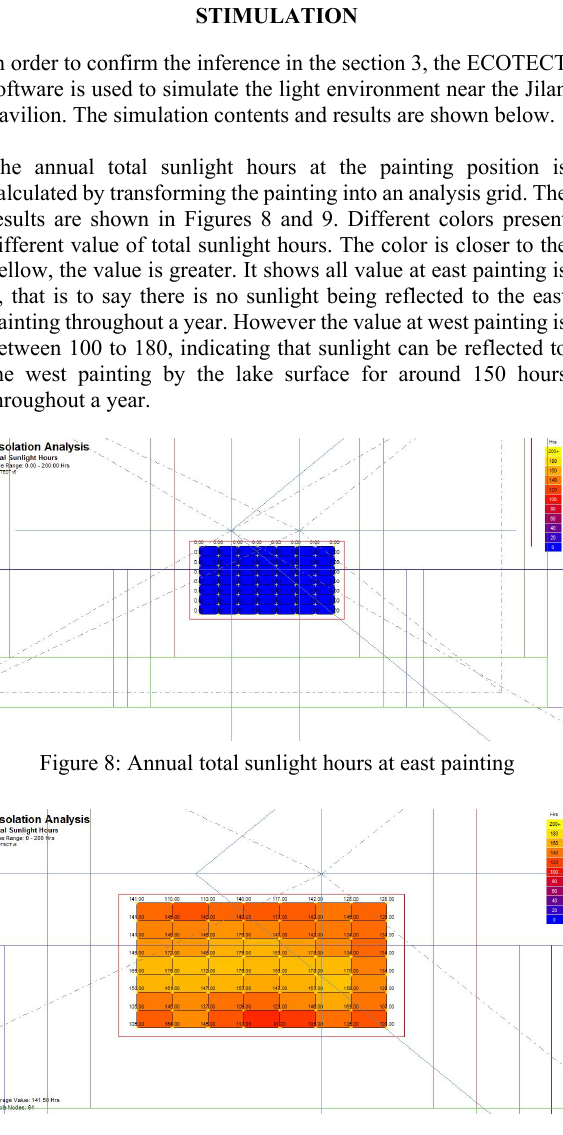
Figure 4: Illuminance comparison diagram